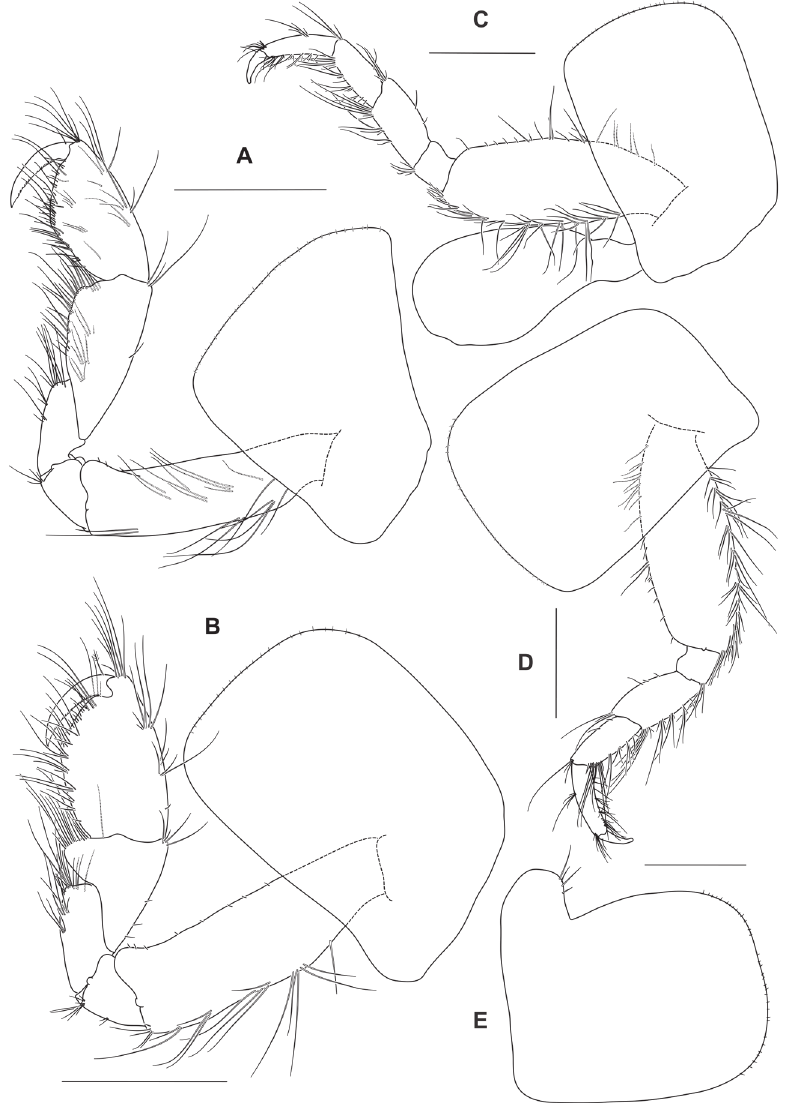
Figure 8. Ampithoe tarasovi Bulycheva, female A gnathopod 1 B gnathopod 2 C pereopod 3 D pereopod 4 E coxa 5. Scale bars: 1 mm ( A–E